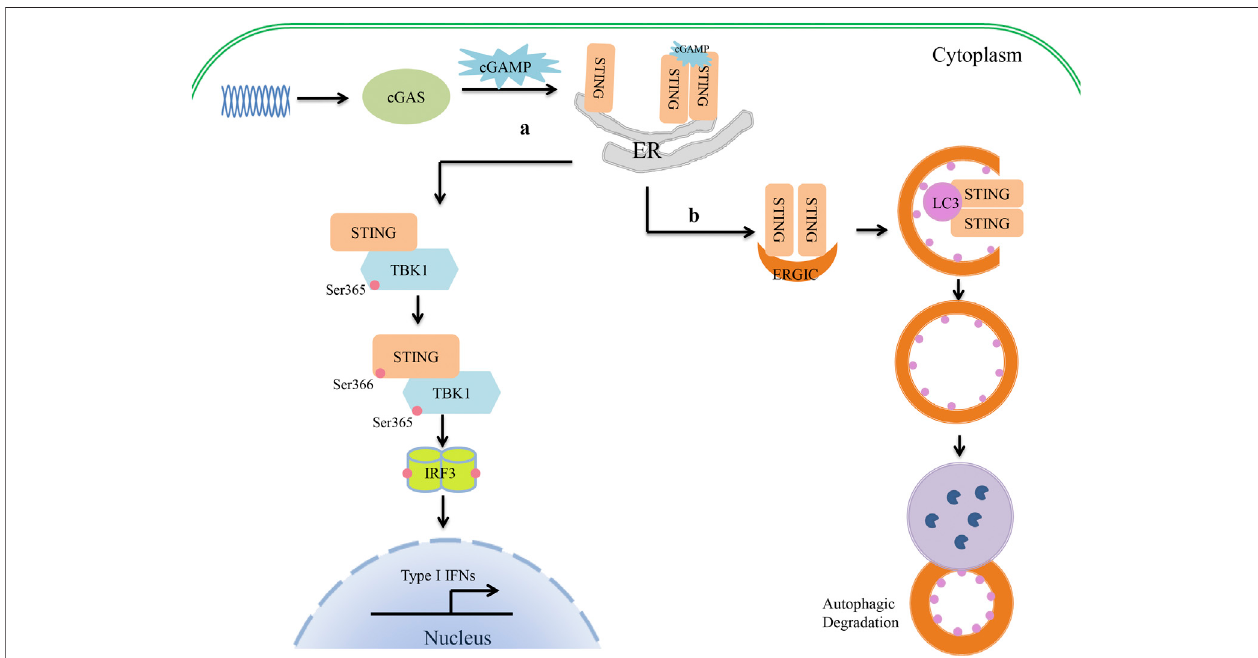
FIGURE 1 | Crosstalk between cGAS – STING signaling and autophagy in type I IFN production. (1) The cyclic guanosine monophosphate/adenosine monophosphatesynthase(cGAS) – stimulatorofinterferongenes(STING)pathwayoftypeIinterferon(IFN)production.cGASrecognizescytosolicDNAandcatalyzesthe formation ofcGAMP. cGAMP serves asasecond messenger that bindsto theCBD domain ofSTING. Upon binding withcGAMP,the conformation ofSTING changes, and oligomerized STING then migrates away from theendoplasmic reticulum (ER).The oligomerization ofSTING activates TBK1 byphosphorylationat serine 365. The activated TBK1 then phosphorylates the CTT pLxIS motif (Ser366) of STING to recruit IRF3. TBK1 in turn phosphorylates IRF3 and induces the IRF3 dimer to enter thenucleus,whereitpromotestypeIIFNproduction.(2)cGAS – STINGtriggersautophagy.OnceSTINGisactivatedbycGAMP,STINGmigratesfromtheERtotheGolgi apparatusviatheER – Golgiintermediatecompartment(ERGIC).AttheERGIC,STINGhasbeenimplicatedinautophagyinduction.STING-containingERGICservesasa membrane source of LC3 lipidation and triggers the formation of autophagosomes. Finally, autophagosomes fuse with lysosomes, where their content is degraded.